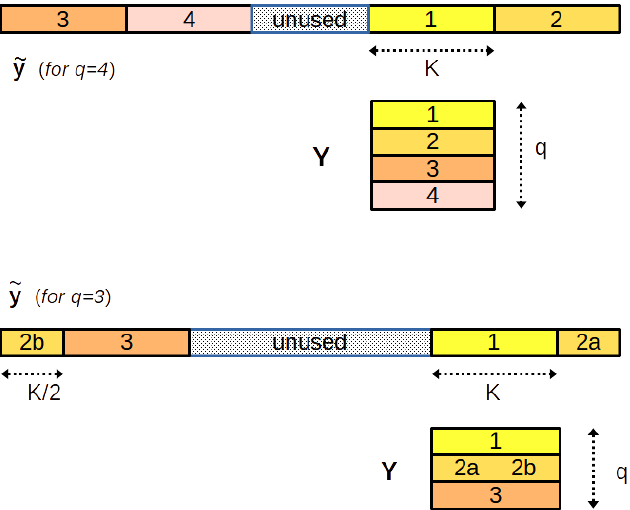
Figure 10. Arrangement of the elements of ˜ y into matrix Y, for q = 4 and q =